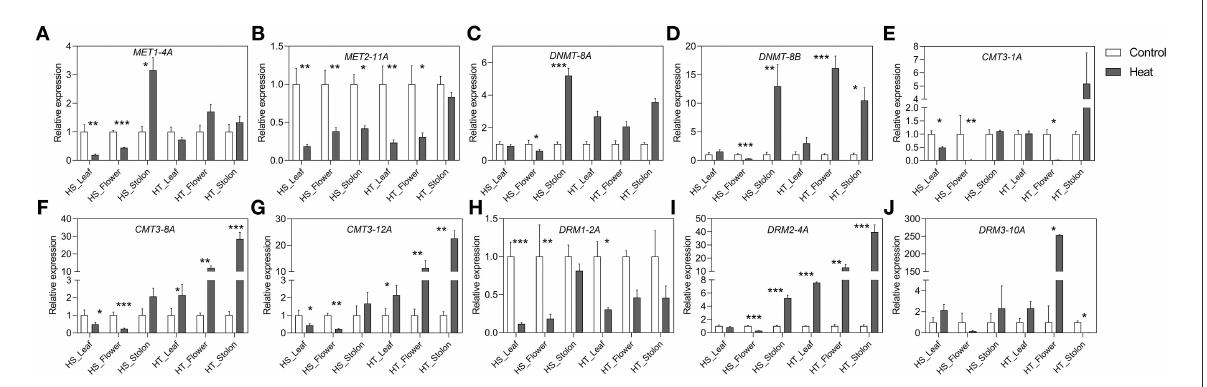
FIGURE5 (A–J) Relative expression levels of potato C 5-MTase genes in different tissues in heat sensitive (HS) and tolerant (HT) genotypes under high-temperature stress. Three biological samples were measured with three technical replicates. The fold change in RNA levels was calculated as the 2– 11 Ct value relative to the mean values obtained in the leaf, flower and stolon samples (set at a value of 1.0). Standard errors of the means are shown with one, two and three asterisks indicating significant differences ( p < 0.05, p < 0.01, p < 0.001, respectively) using a student’s t -test.